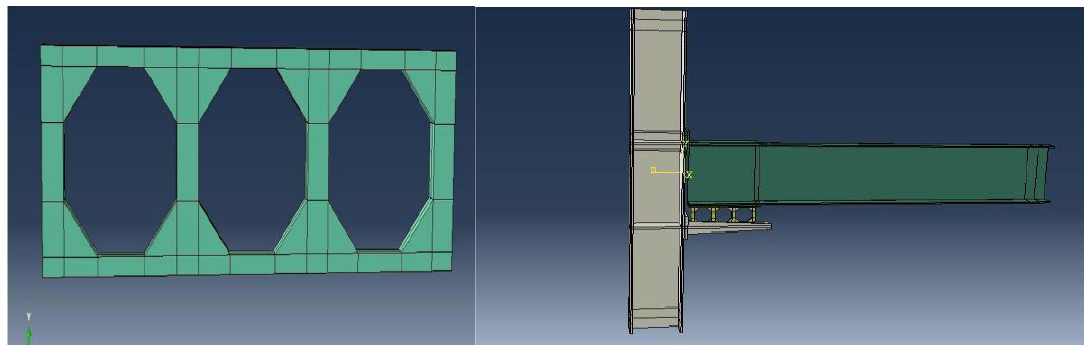
Figure 2. Cubical shapes of slit beam-column